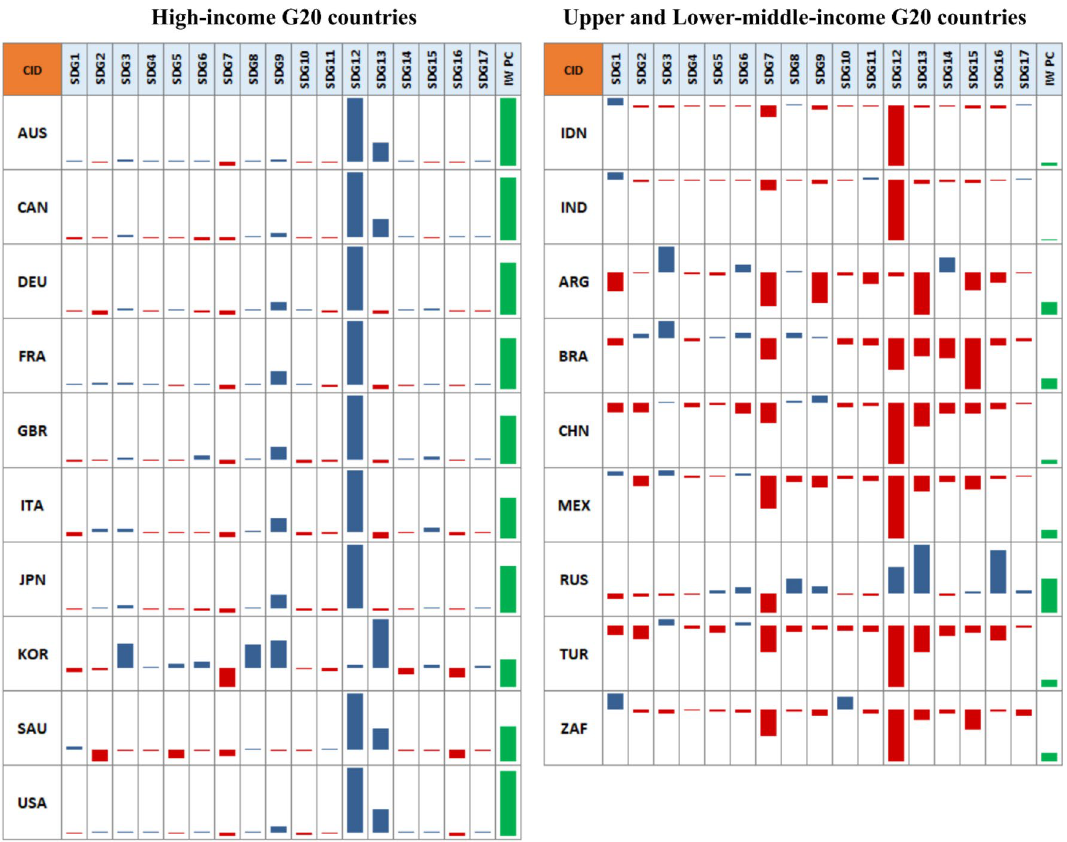
Figure 4. Local interpretation of the SDGs-wealth model based on the SHAP values for G20 countries. Decomposition of a single prediction in our SDGs-wealth model using the SHAP force plot provided by the R package shapviz 43 . The SHAP values from the SHAP force plots were extracted and modified into column sparklines. The blue bar indicates a positive contribution to the predicted value, while the red bar indicates a negative contribution. The bar’s length indicates the contribution to the predicted value relative to other independent variables. The green bar indicates the predicted value (per capita IW